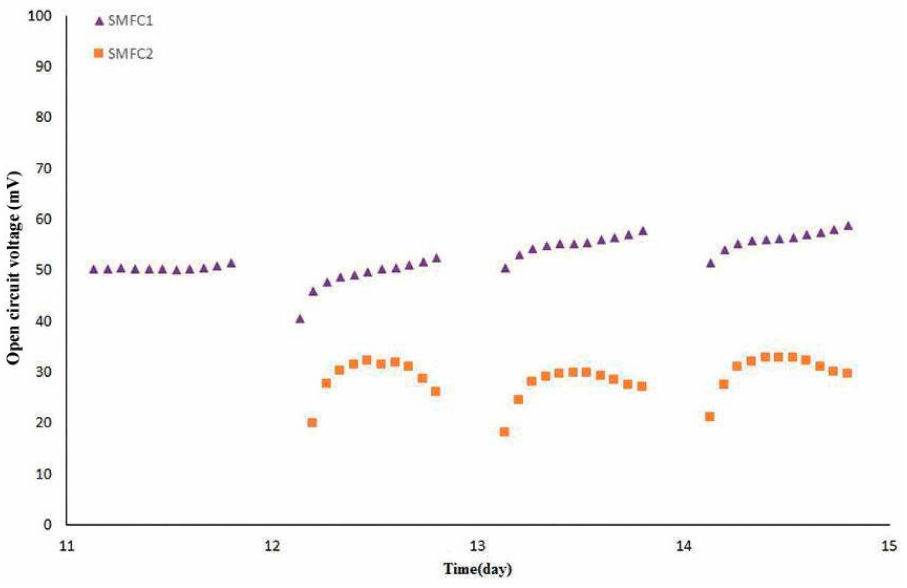
Figure 3. Steady stage and reproducibility of the